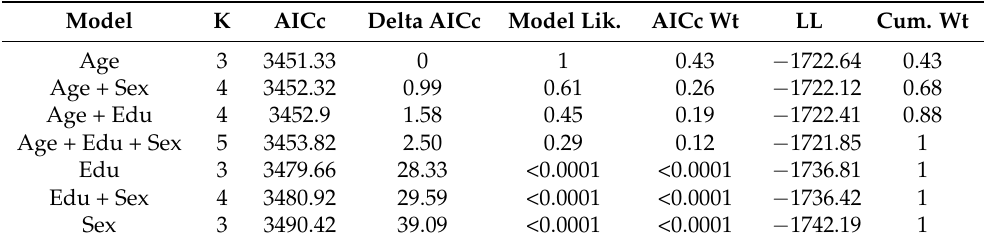
Table 9. Comparison between regression models with the best transformation of independent vari- ables for the mean execution time. K = Number of parameters of the model; AICc = Akaike’s Infor- mation Criterion corrected; Delta AIC = AIC difference between the best model and the model listed; Model Lik. = the relative likelihood of the model; AICc Wt = model probabilities; LL = log-likelihood of the model; Cum. Wt = cumulative Akaike weights.